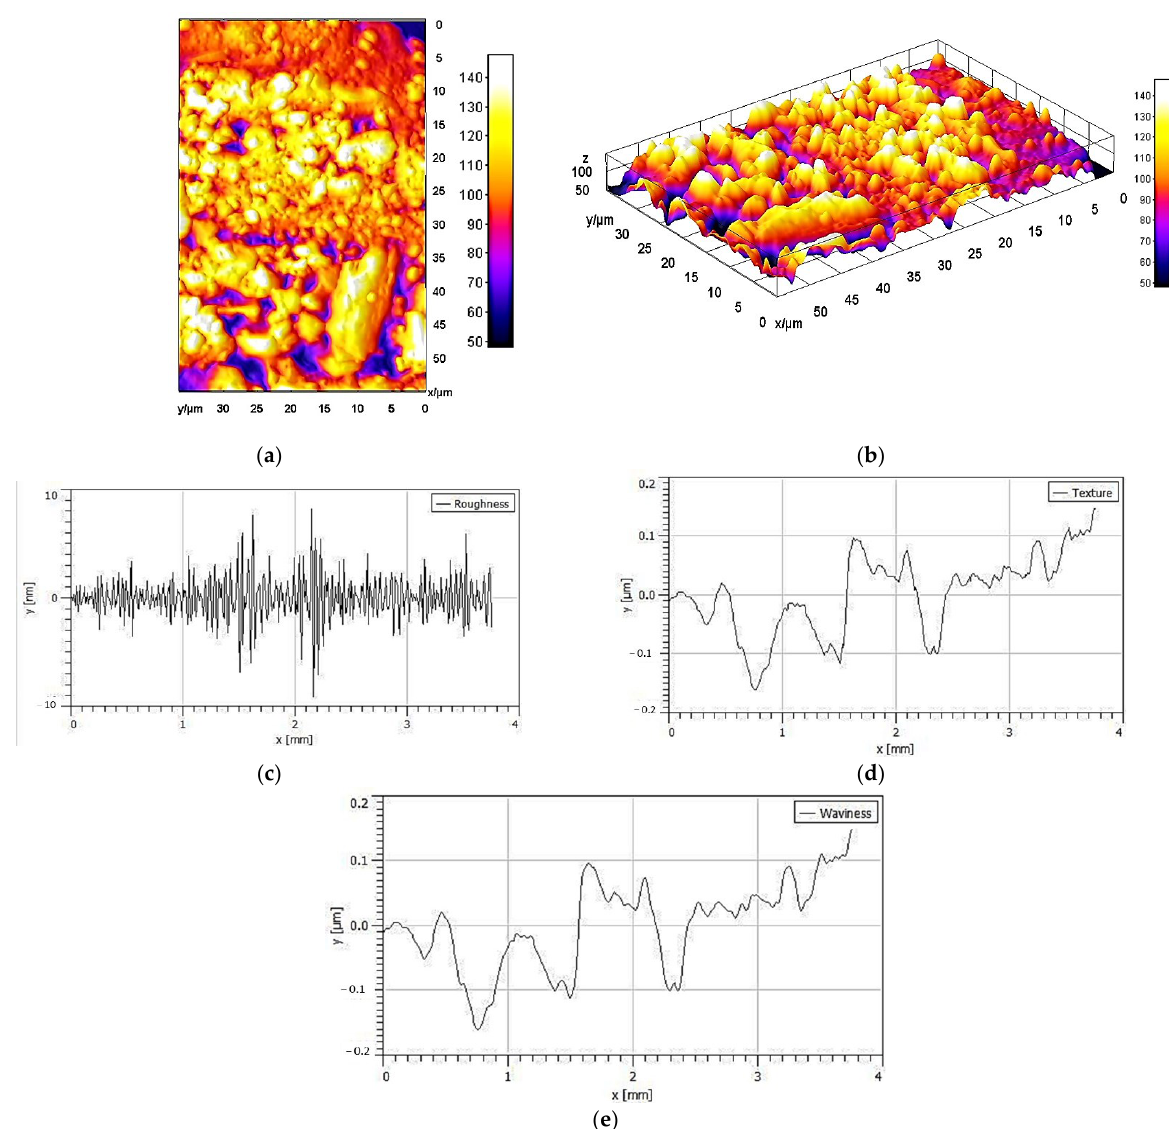
Figure 7. Atomic force microscopic analysis of EPSR4 representing the topology in 2D ( a ) and 3D ( b ), roughness ( c ), texture ( d ), and waviness profile ( e ) of EPSR4.